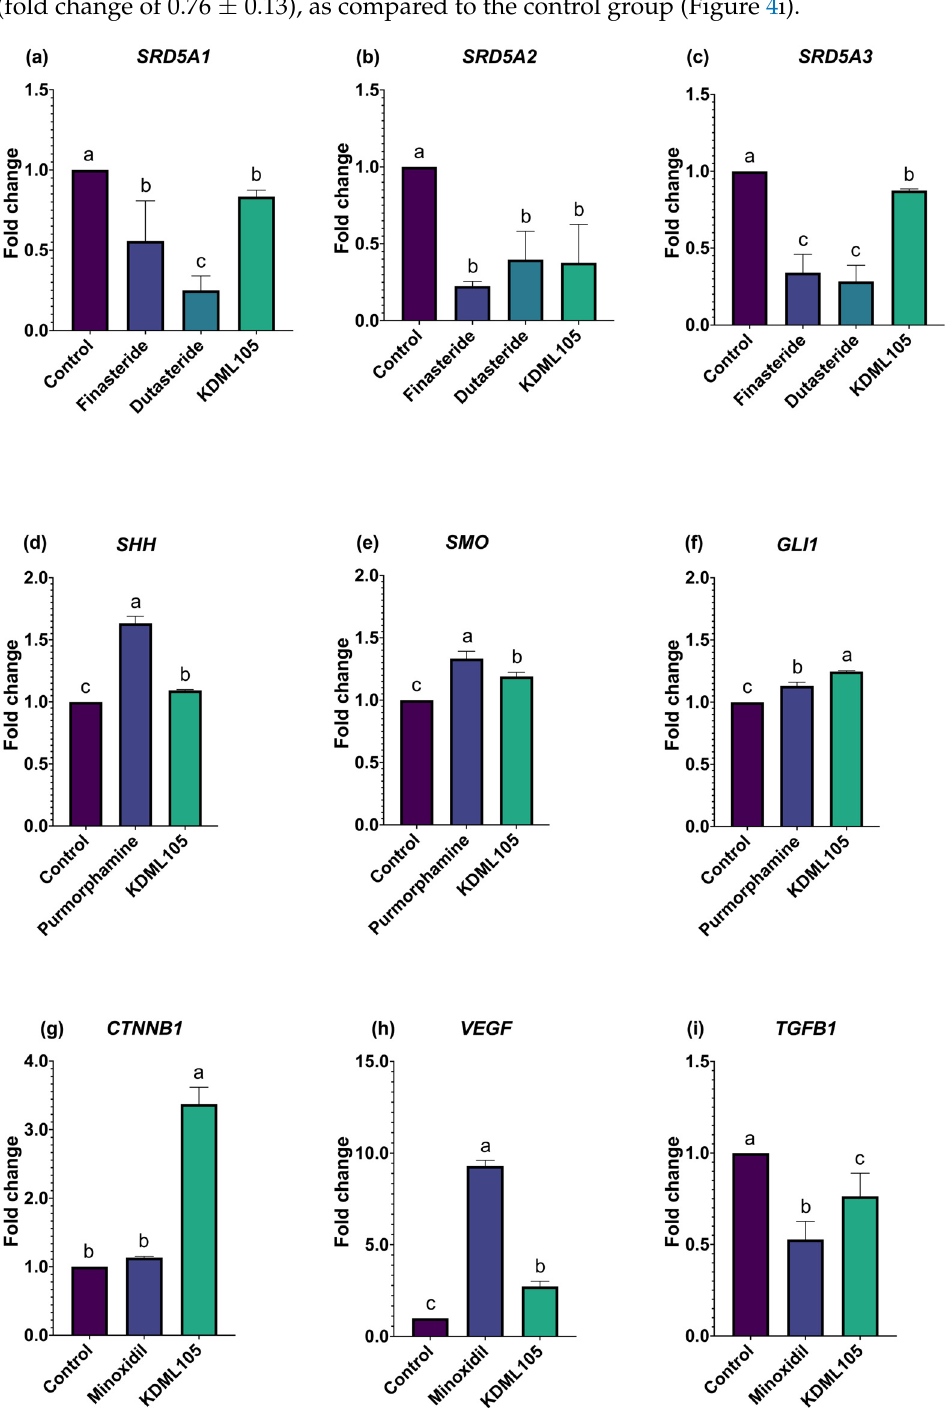
Figure 4. Gene expression profiling of human hair follicle dermal papilla cells (HDCPCs) in response to Oryza sativa L. cv. Khao Dawk Mali 105 (KDML105) bran extract was compared to the vehicle-treated control and standard reference compounds, including finasteride, dutasteride, purmorphamine, and minoxidil, at the same concentration of 0.1 mg/mL. Examined genes relating to hair growth consist of ( a ) SRD5A1 , ( b ) SRD5A2 , ( c ) SRD5A3 , ( d ) SHH , ( e ) SMO , ( f ) GLI1 , ( g ) CTNNB1 , ( h ) VEGF , and ( i ) TGFB1 genes. Different alphabets represent significant differences ( p < 0.05) between groups.